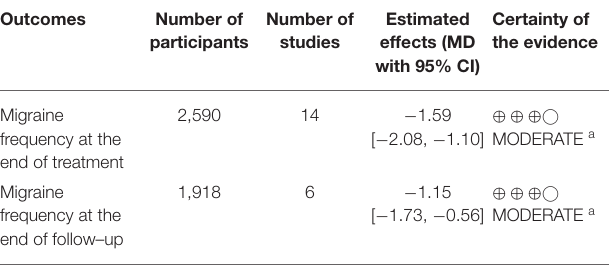
TABLE 6 | Summary of adverse